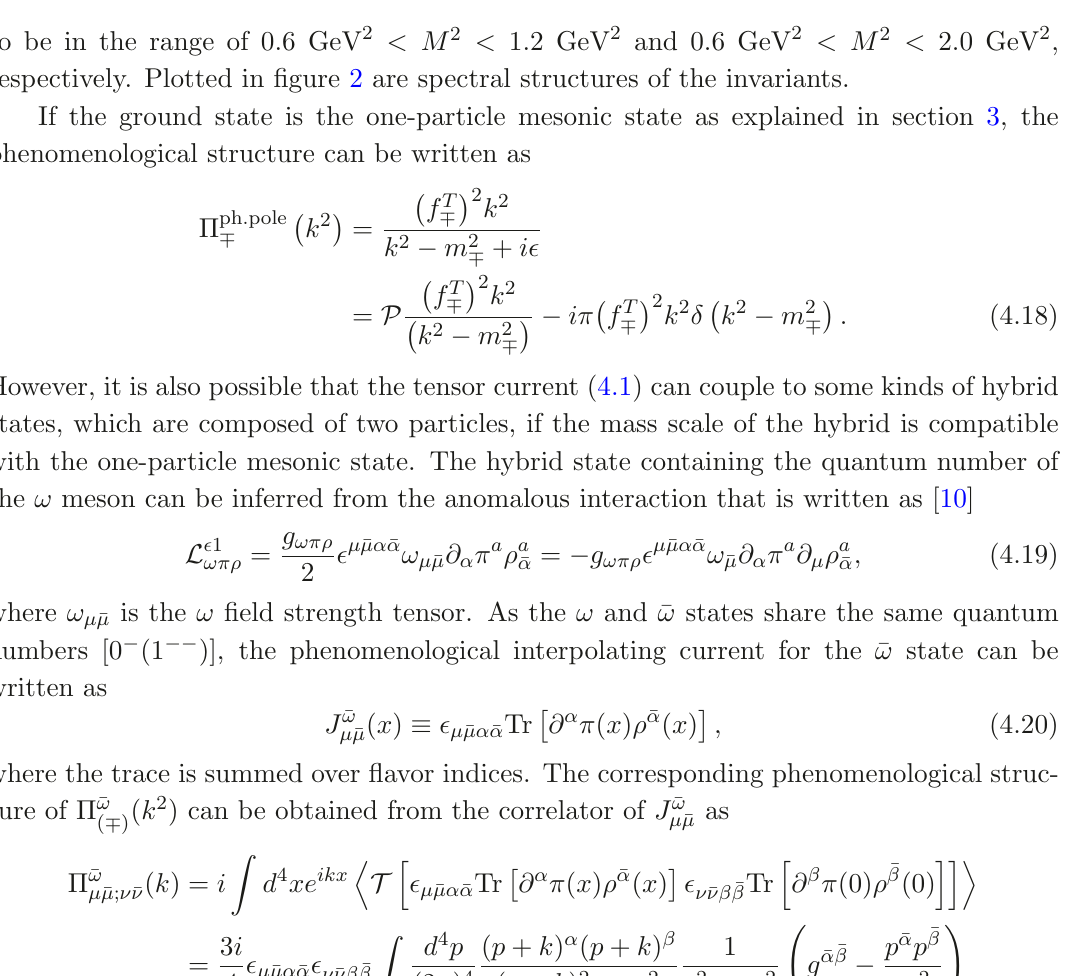
Figure 2 . Spectral structure of the weighted invariant (a) for the ¯ ω and (b) for the ¯ b 1 . As a reference, black dotted lines are given to denote